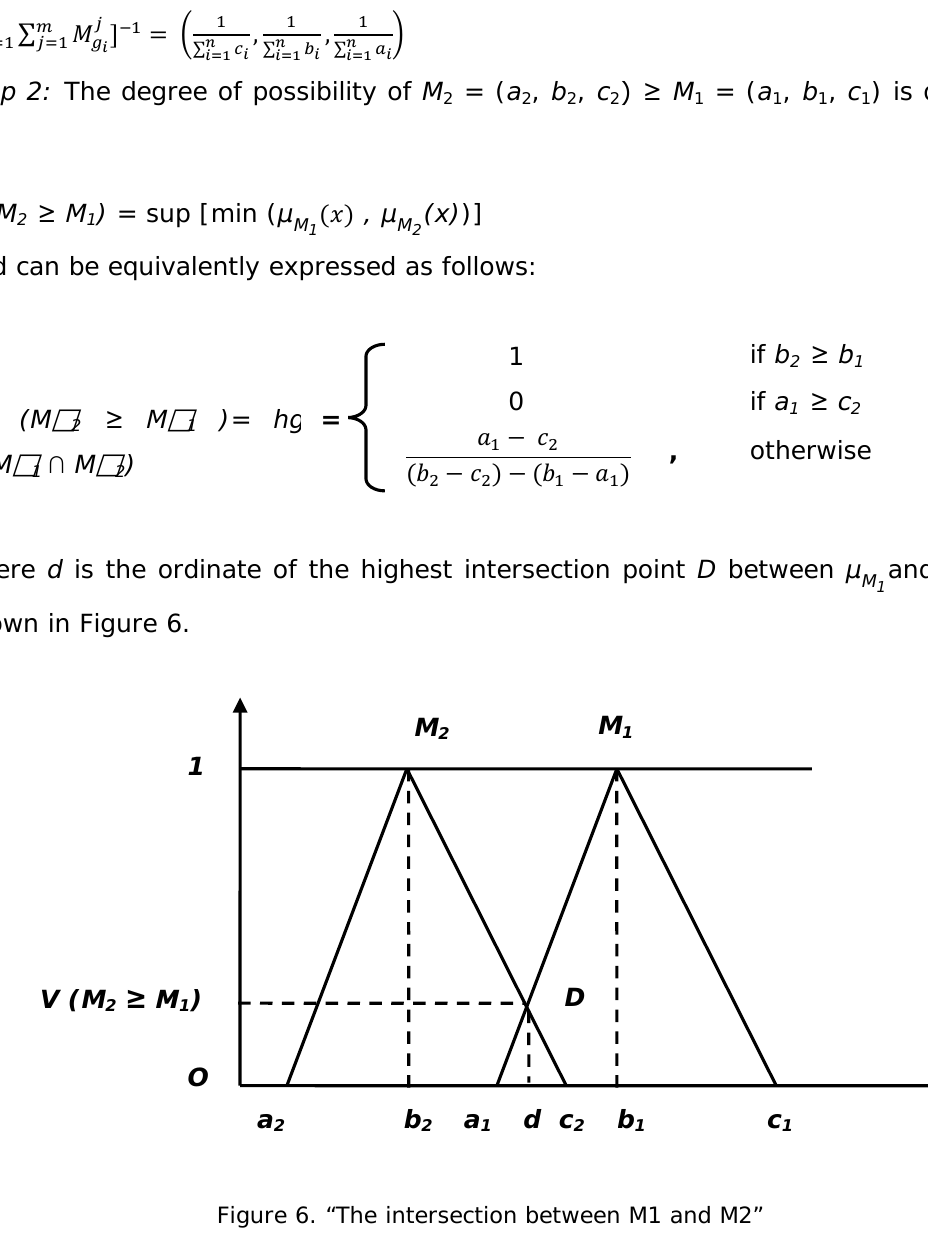
Figure 6. “The intersection between M1 and